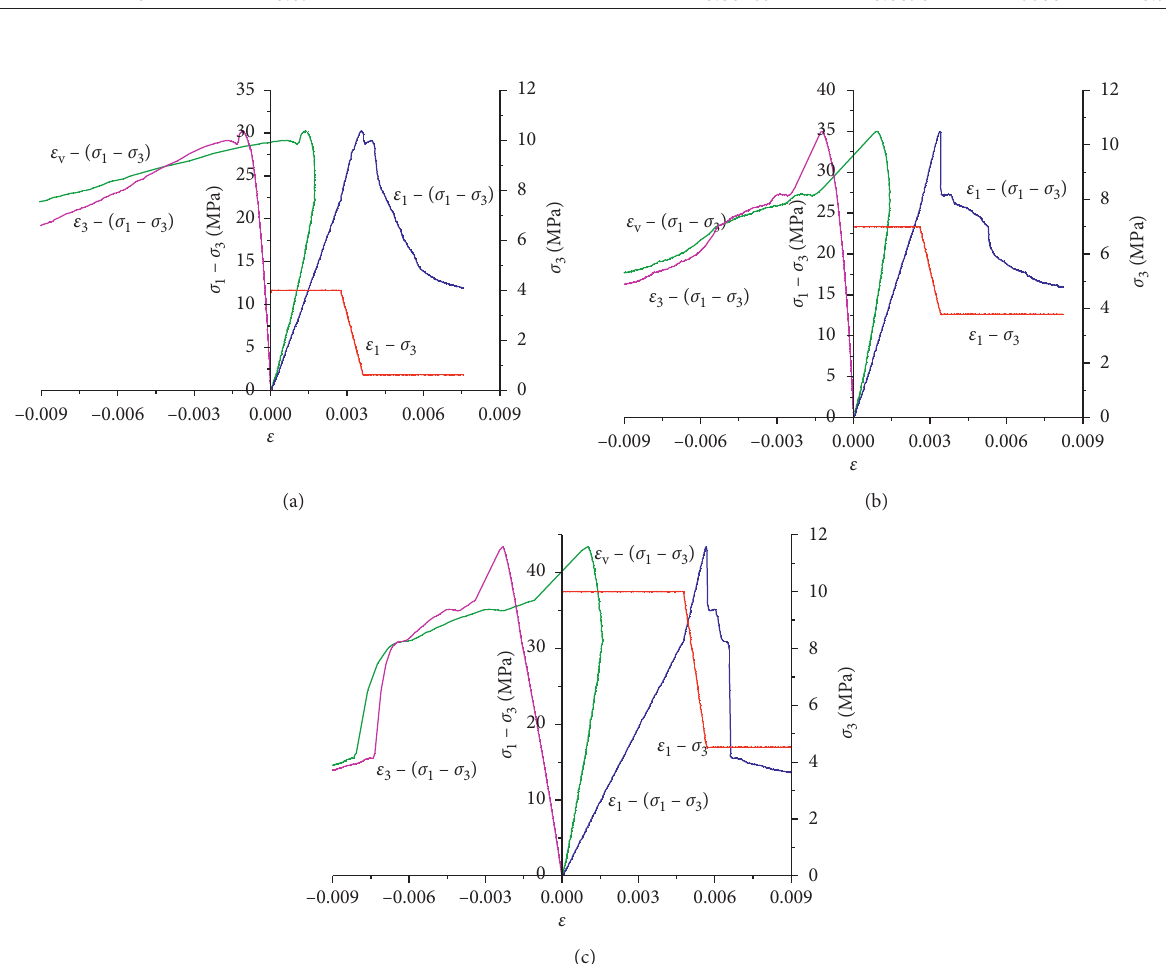
Figure 4: Stress-strain curves of confinement unloading test of coal samples. (a) C-4-0.05, (b) C-7-0.05, and (c)